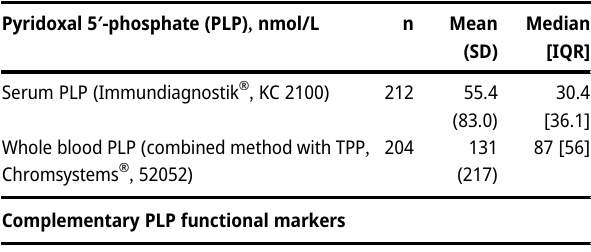
Supplementary Table S2), the concentrations of tHcy and Cys were highest when both serum and whole blood PLP were below the corresponding medians. The group with serum PLP below the median, but whole blood PLP above the me- dian (n=20) appeared to have higher levels of tHcy and Cys, whereas the group with only whole blood PLP below the median had rather low mean tHcy and Cys (Supplementary Table S2). Similar results were obtained when the cut o ff